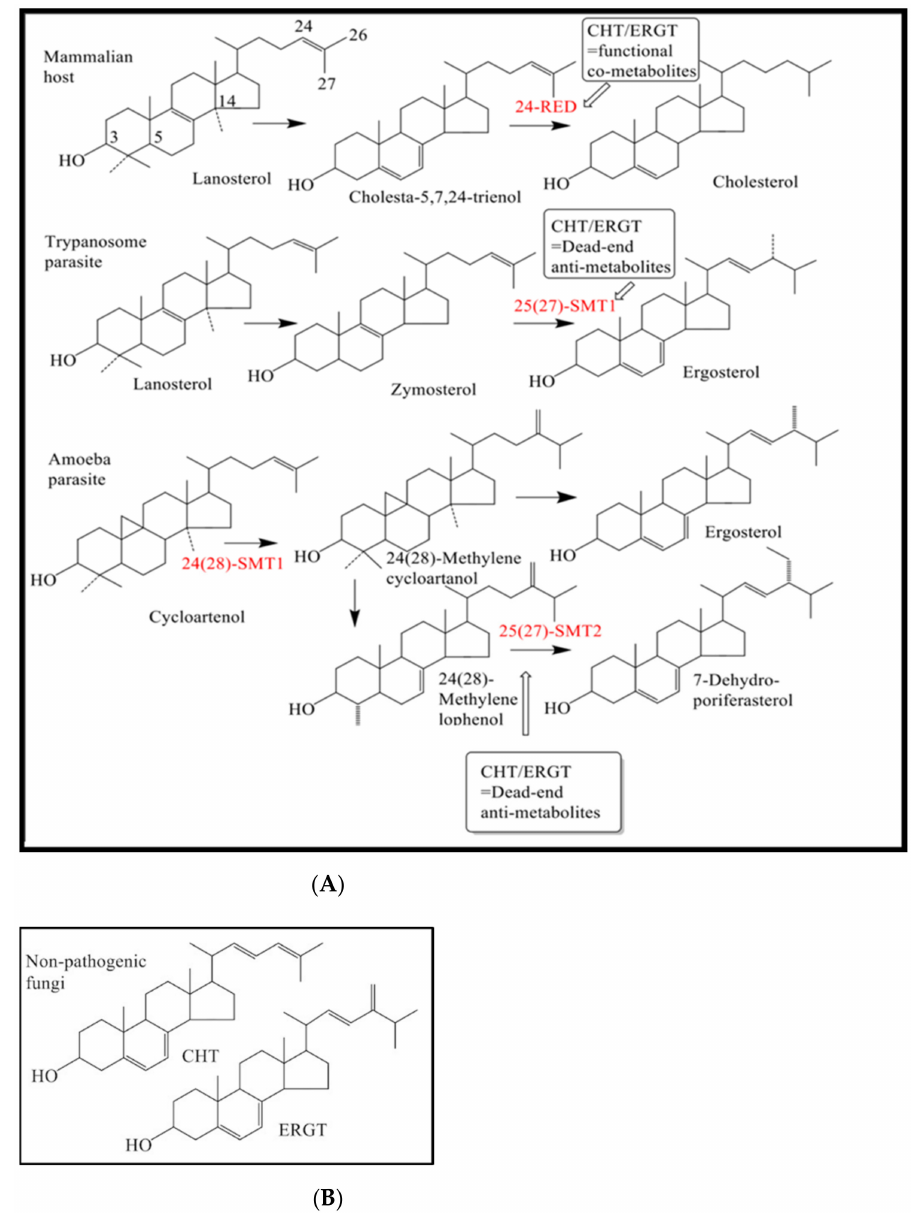
Figure 1. Differences in inhibition of steroidogenesis affected by steroidal antimetabolites. As shown, in ergosterol synthesis CHT and ERGT specifically inhibit the D25(27)-SMT in Tb and Ac via suicide (irreversible) inhibition. Alternatively, in cholesterogenesis neither CHT nor ERGT attach irreversibly to any enzyme in the pathway ( A ). Antimetabolites ERGT and CHT derived from yeast ( B